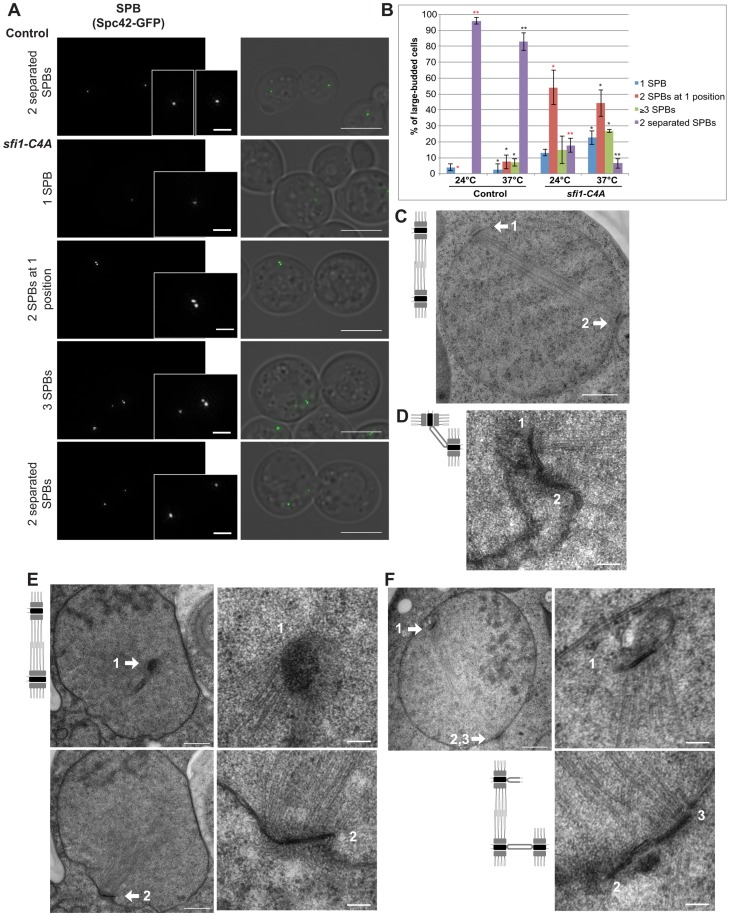

sfi1-C4A displays unseparated SPBs or bipolar spindles with enlarged or reduplicated SPBs.
A. Asynchronous sfi1-C4A SPC42-GFP (JA302) and SFI1 SPC42-GFP (JA254) control cells grown at 24°C and shifted to 37°C for 9 h in YPD. Fixed large-budded cells were imaged by SIM. GFP on left (inset bar: 1 µm) and merge with transmitted image on right. Bar: 5 µm. B. Quantification of A. Asterisks: statistically significant difference via Student's t test between sfi1-C4A and control for each phenotypic category at 24°C (red) and 37°C (black). **p<0.01. *: p<0.05. Significance only shown for comparisons between strains at each temperature. Error bars: SD. n≥77 cells per group from 2 experiments. C. Asynchronous control cells (JA196) shifted to 37°C for 4 h in YPD and prepared for EM. Bipolar spindle with two SPBs (1, 2). Bar: 500 nm. D–F. Asynchronous sfi1-C4A (JA249) cells shifted to 37°C for 9 h in YPD and prepared for EM. Serial sections were examined by EM for 18 cells. D. Representative cell (n = 11) with two SPBs at one position. SPBs (1, 2) are at abnormal orientations to one another with a bridge. Bar: 100 nm. E–F. Multiple sections from the same cell are shown. Left panel(s): entire nucleus, 500 nm bar. Right panels: SPB(s), 100 nm bar. E. Representative cell (n = 2) containing a short bipolar spindle with SPB 1 at an orientation different from that of abnormally large SPB 2. F. Representative cell (n = 5) containing a short bipolar spindle with extra SPBs. SPB 1 is located at a region of the nuclear envelope opposite SPBs 2 and 3, which are connected via a bridge. Left panel shows the location of SPB 1, shown in the upper right panel at higher magnification, and SPBs 2 and 3. In the lower right panel, both SPBs 2 and 3 are clearly seen in a higher magnification view from a different serial section of the same cell. Average distance between adjacent SPBs: 108±10 nm.